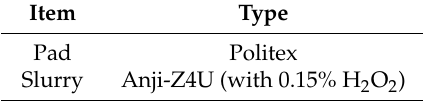
Table 1. Specifications of the pad and slurry.